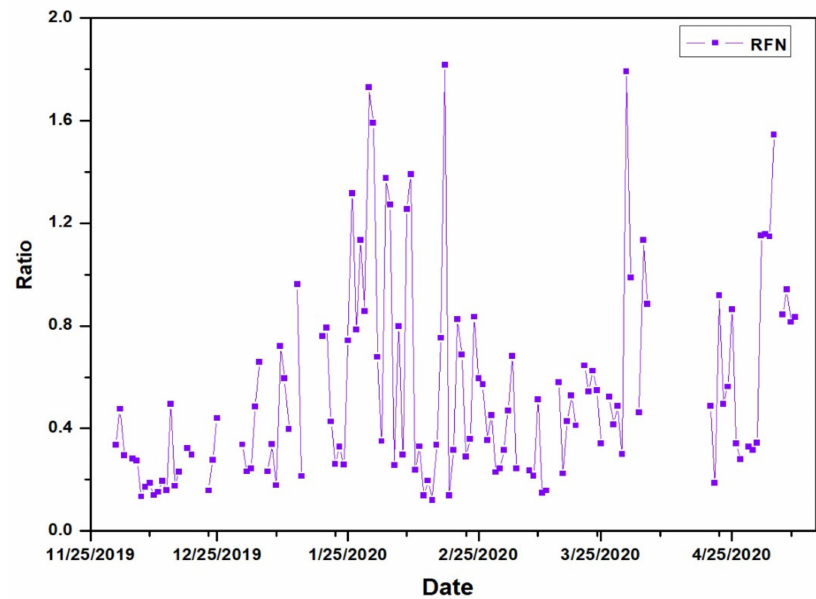
Figure 8. Daily averaged HCHO / NO 2 ratio at Nanjing.